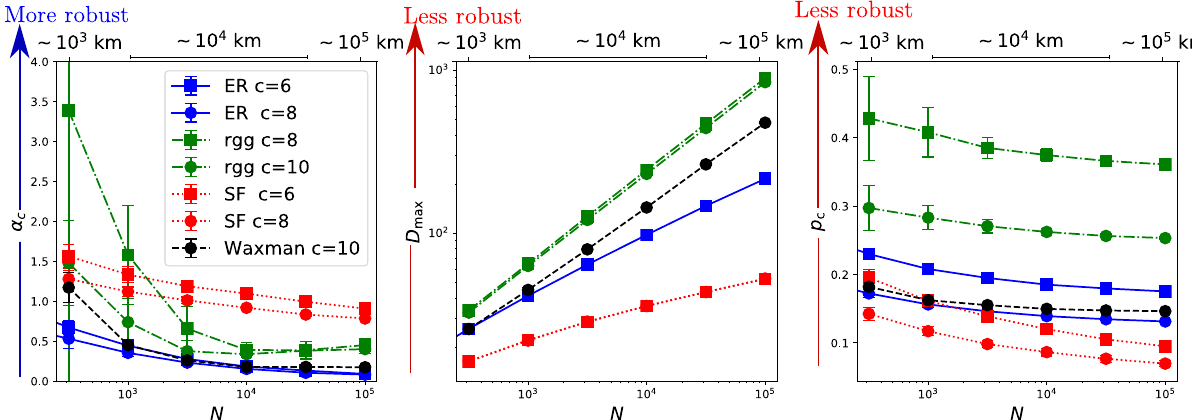
Fig. 6 Robustness of the network as a function of its topology. Shown are the three critical parameter the critical classical quantum-repeater ef fi ciency, α c , the critical classical percolation probability, p c , and the critical network diameter D fi ciency α c is the max . The critical classical quantum-repeater ef required quantum-repeater ef fi ciency necessary to avoid the phase transition for a given network. The classical critical percolation probability, p c in the minimum probability that a link is not removed, in order to have the network in the connected regime. The relation between the critical classical percolation probability in our model p c ð c and the classical critical percolation probability, p c depends on the third parameter the critical network diameter D max , see Eq. 2 Þ ((5)). The critical network diameter D max is the diameter of the network at the phase transition point. In the left, center, and right panel these are shown for the Erd ő s-Rényi (ER), Barabási-Albert (SF) geometric graphs (rgg), and the Waxman networks for N varying between 10 2.5 – 10 5 . For a network to be robust we want α c and p c to be as large as possible with D max to be as small as possible. We estimate the parameters above based on 100 network realization for each network model and value of c . For each network D ( p ) was computed based on 100 runs. Error bars show the standard deviation associated with each estimation. Show in the upper axis is estimation of the order of magnitude for physical range of the two geometric network (rgg and Waxman) assuming a connecting radius of 266 km (see Supplementary Note 6 and Note 7, and Table